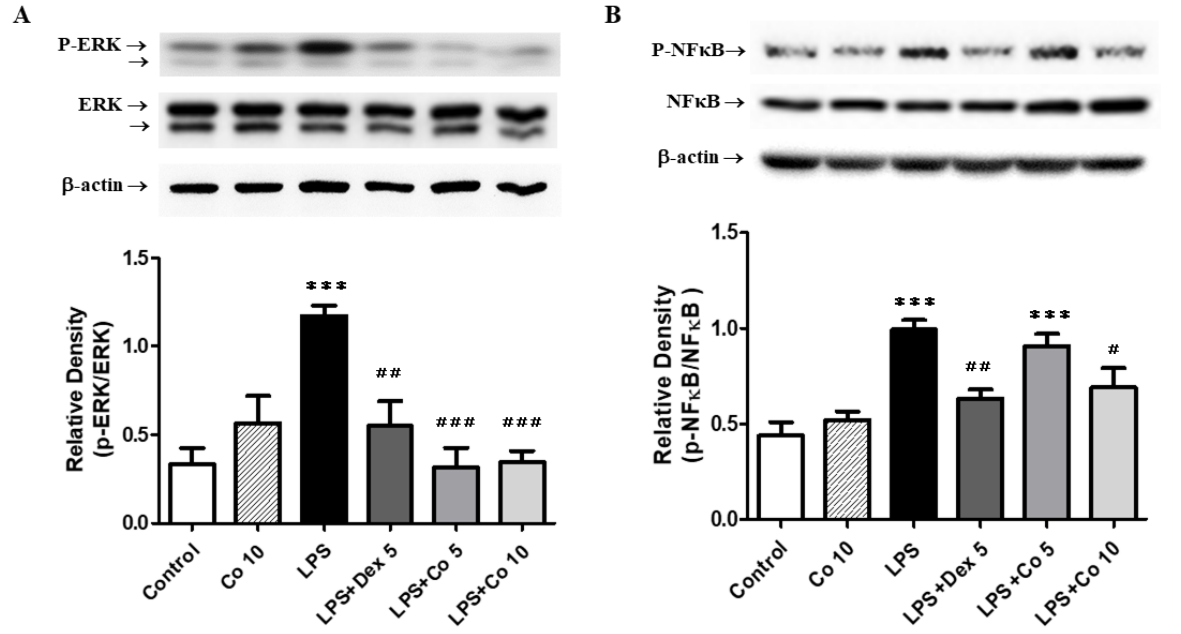
Figure 7. Effects of corilagin on lung (A) ERK and (B) NF- κ B expression in LPS-induced ALI . After intratracheal LPS challenge for 30 min, the mice were administered with Dex (5 mg/kg), corilagin (5 and 10 mg/kg), or equal volume of saline intraperitoneally. Mice were sacrificed, and lung tissues were obtained after 6 h of LPS challenge. The expression levels of ERK and NF- κ B were detected by Western blot analysis. Equal protein loading is illustrated by the β -actin bands in all lanes. The bands were analyzed using densitometry, and each value represents mean ± SEM of six mice per group. *** p < 0.005 vs. control; # p < 0.05, ## p < 0.01, ### p < 0.005 vs. LPS alone.